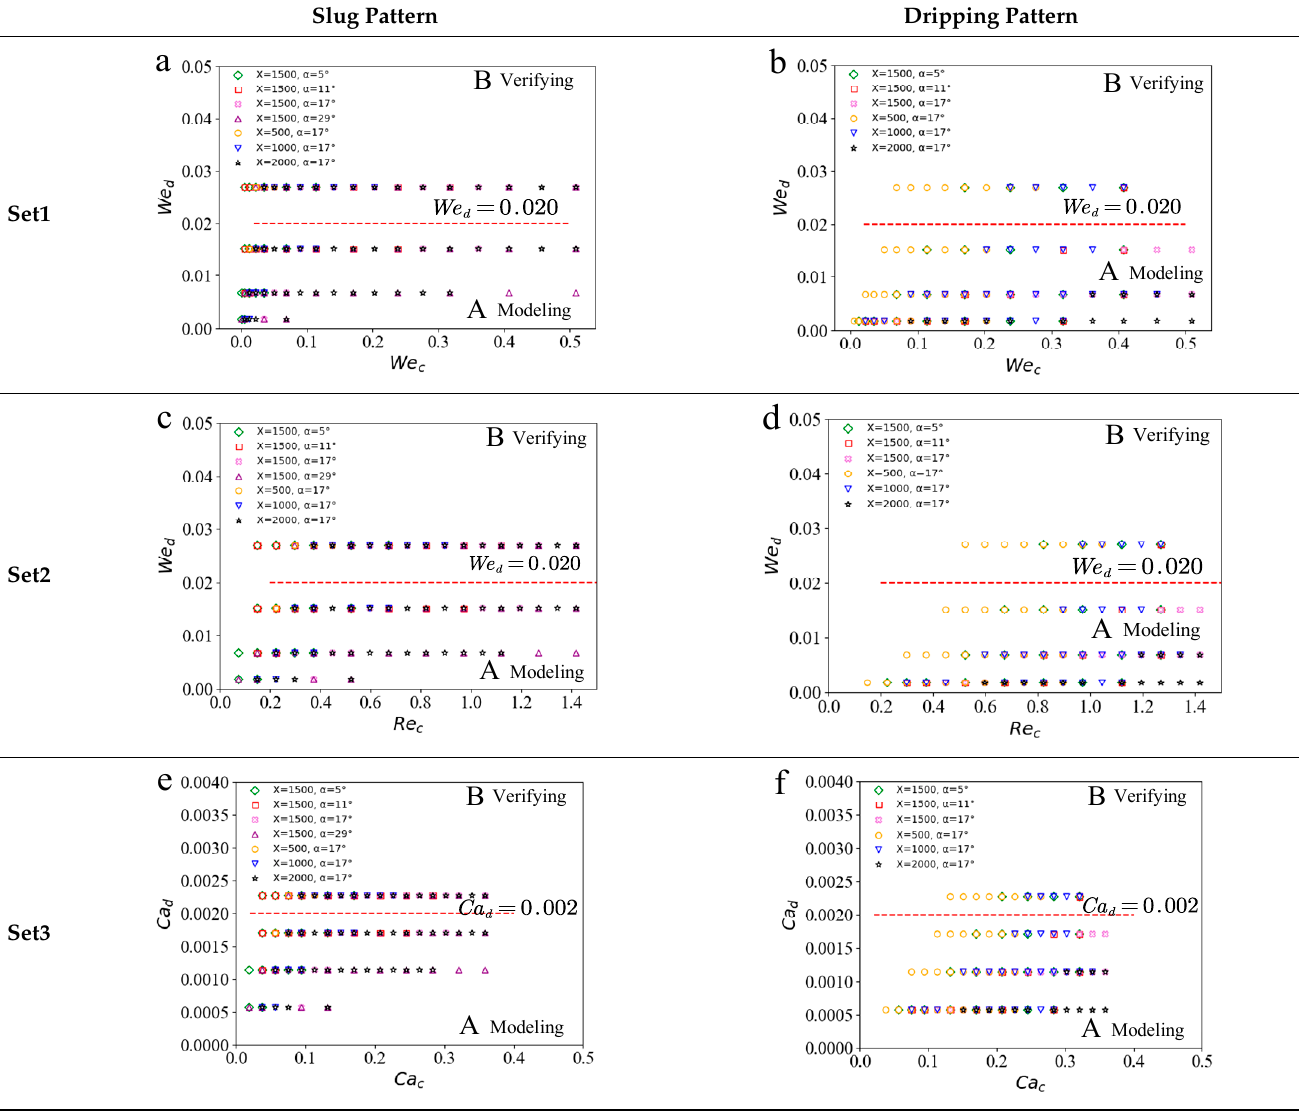
Table 5 is the data partition of slug and dripping patterns in three sets in Experiment 2. The partition line adopted the same parameters following it in Experiment 1. Table 5. Data partition of three sets with dimensionless numbers in Experiment 2: ( a ) slug in Set1, ( b ) dripping in Set1, ( c ) slug in Set2, ( d ) dripping in Set2, ( e ) slug in Set3, and ( f ) dripping in Set3.